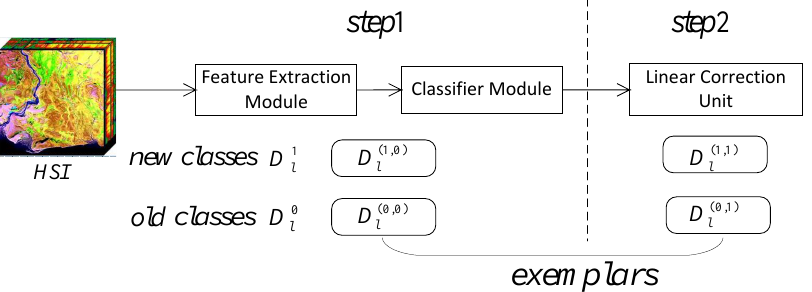
Figure 5. The diagram of data distribution method: The training samples of the new classes and exemplars of the old classes are divided into training and balanced sets. The training set is used for the feature extraction module and classifier module, and the balanced set for linear correction